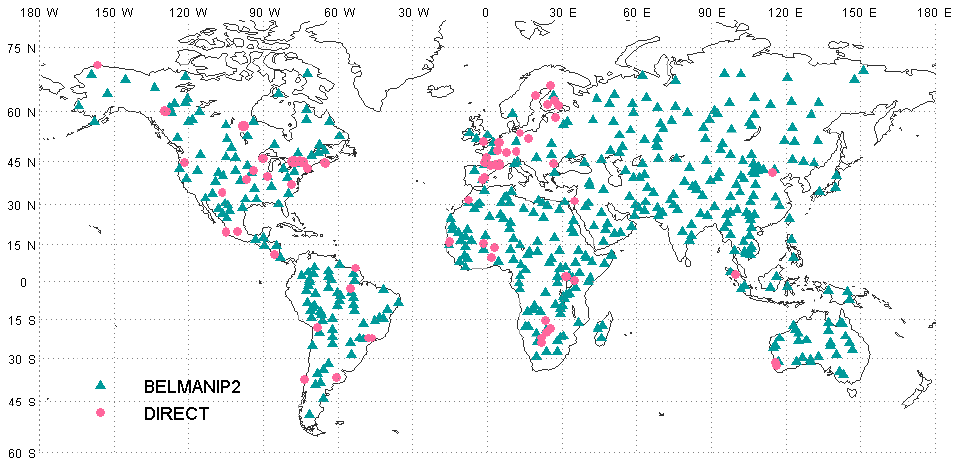
Figure 1. BELMANIP-2 and DIRECT network site locations (http://calvalportal.ceos.org/web/olive/site-description).